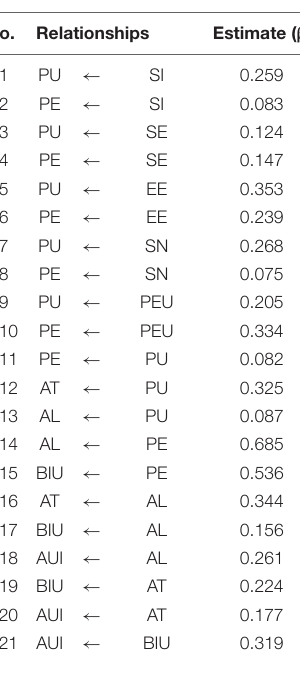
TABLE 6 | Hypotheses testing